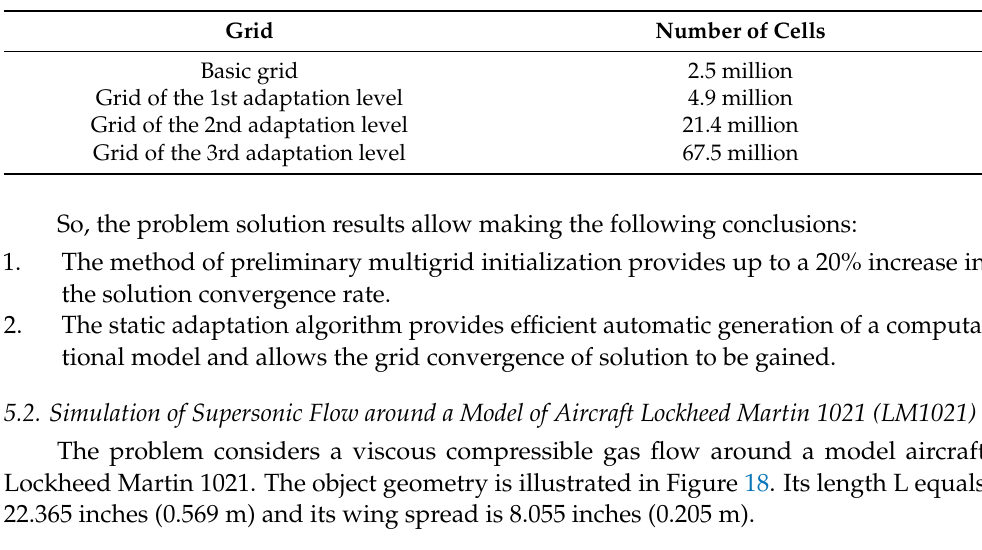
Table 2. Characteristic features of computational grids.